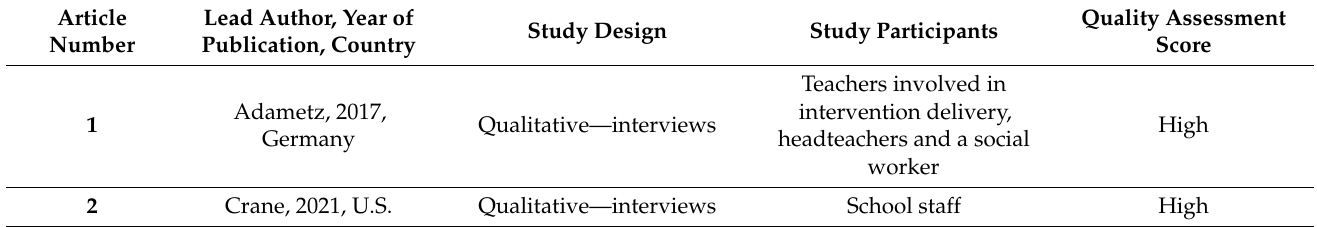
Table 3. Study design and quality